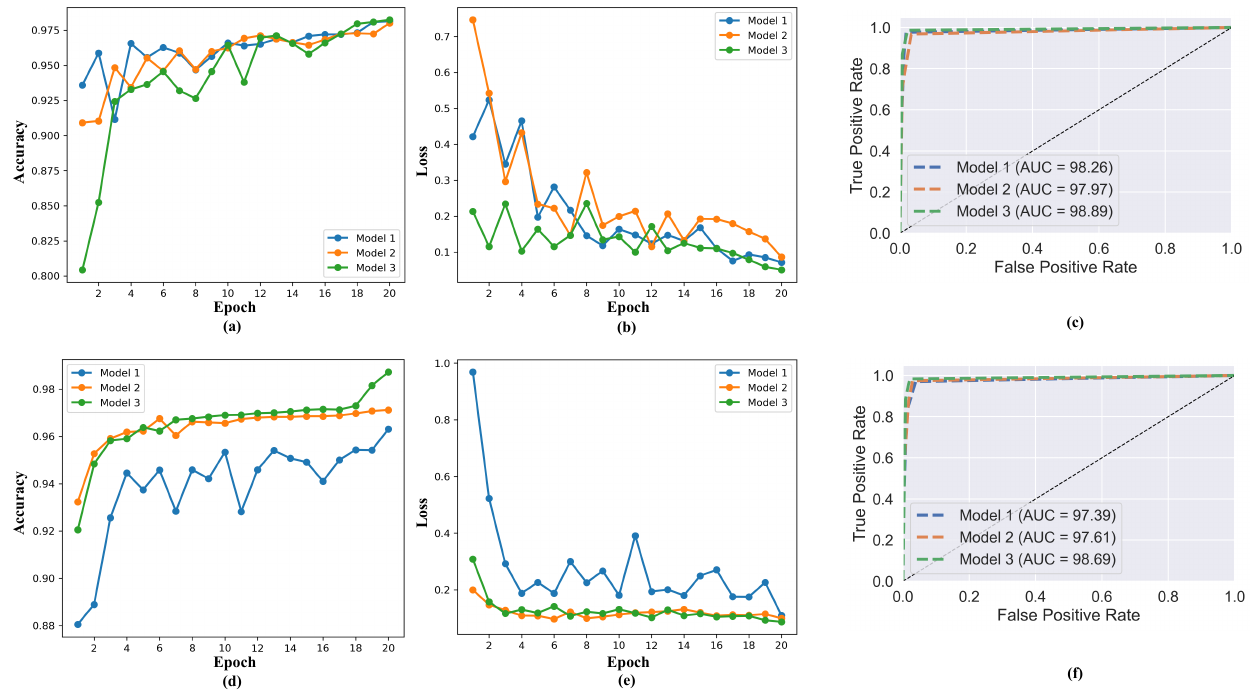
Figure 6. Performance comparison of the three models in terms of validation accuracy and loss. The ( a – c ) presents the performance of the three models on three classes, while the ( d – f ) presents the performance on four